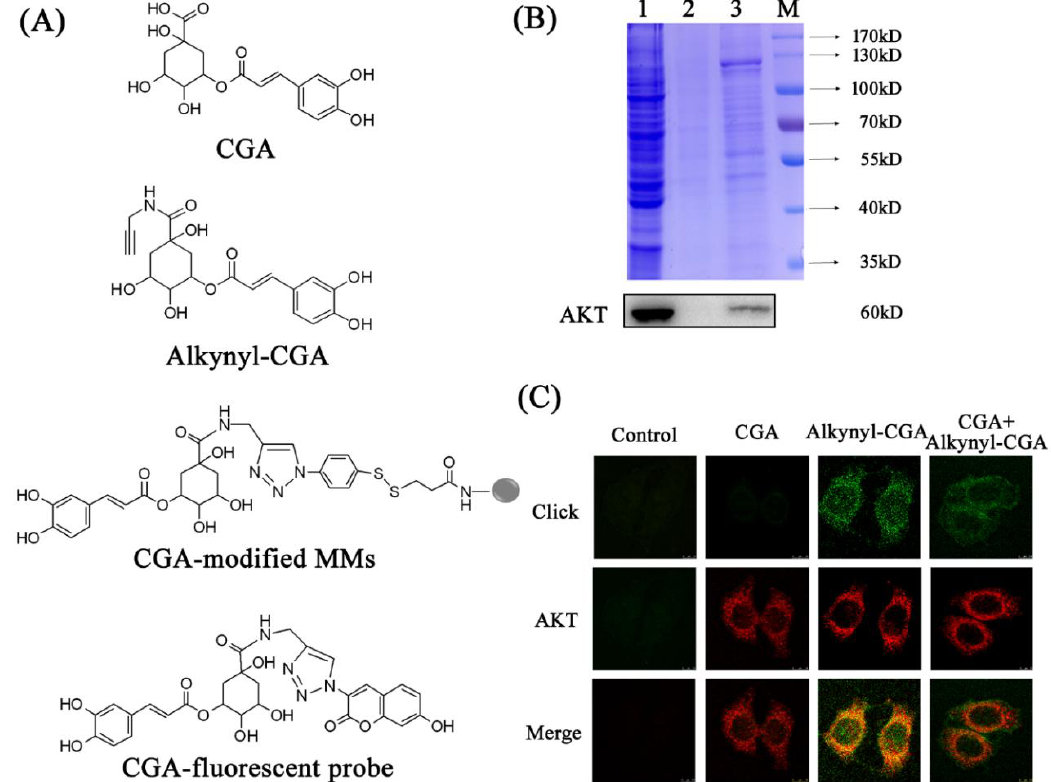
Figure 2. The chemical structures of the compounds used and results of target fishing. ( A ) The chemical structures of CGA, alkynyl-CGA, CGA-modified magnetic microspheres (MMs), and the CGA-fluorescent probe. ( B ) SDS-PAGE (upper panel) and Western blot analysis (lower panel) were used to detect proteins enriched by CGA-modified MMs in HepG2 cells. Lane 1: total protein content of the HepG2 cell lysate. Lane 2: the protein enriched from HepG2 cell lysate by azide-modified MMs. Lane 3: the protein enriched from HepG2 cell lysate by CGA-modified MMs. M: marker. ( C ) Co-localization of the CGA-fluorescent probe (green) and AKT antibody (red) in HepG2 cells (magnification 200 ×